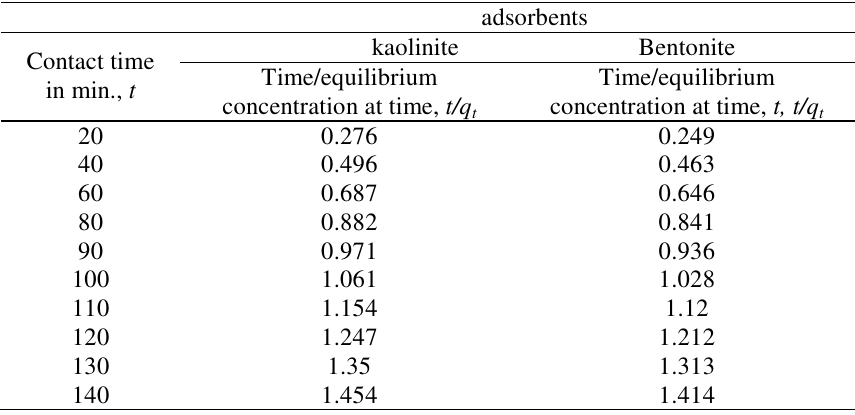
adsorbents kaolinite Bentonite